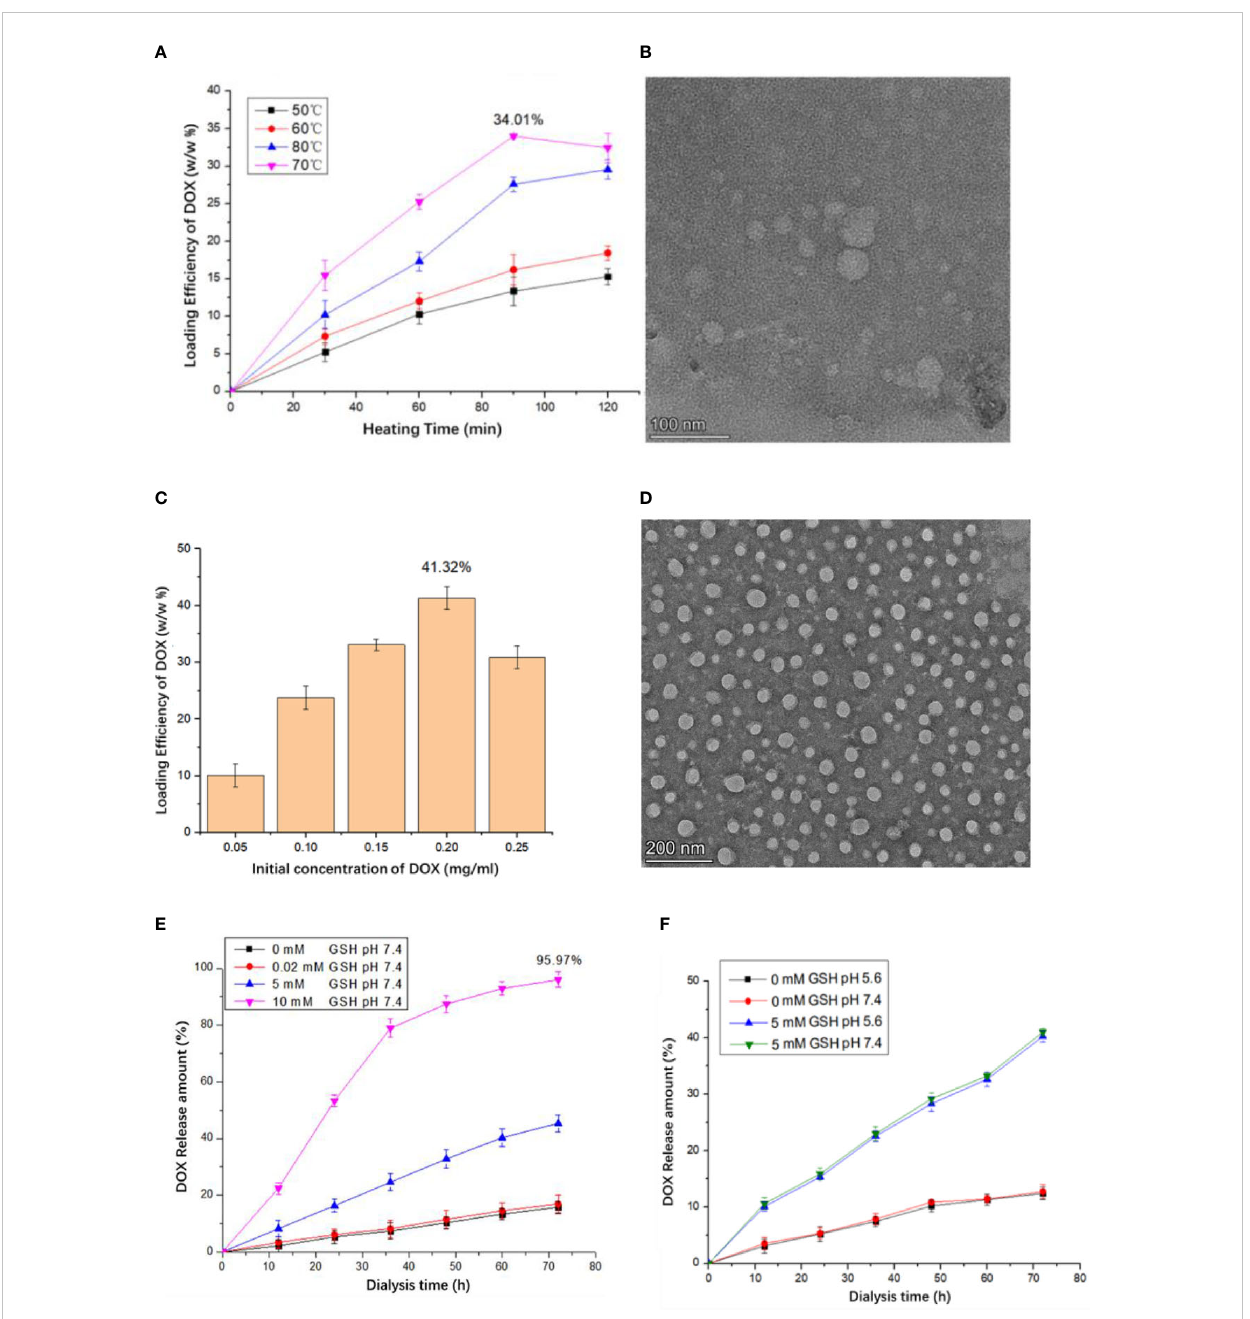
FIGURE 2 Production of the HBc-DOX VLPs and in fl uence of different concentrations of GSH and Ph on drug release of HBc-DOX particles. (A) DOX loading at different heating temperatures and times. (B) TEM observation of HG particles heated at 70°C for 120 min. (C) Relationship between DOX concentration and loading rate. (D) HBc-DOX particles observed by TEM. (E, F) In fl uence of different concentrations of GSH (E) and Ph (F) on drug release of HBc-DOX